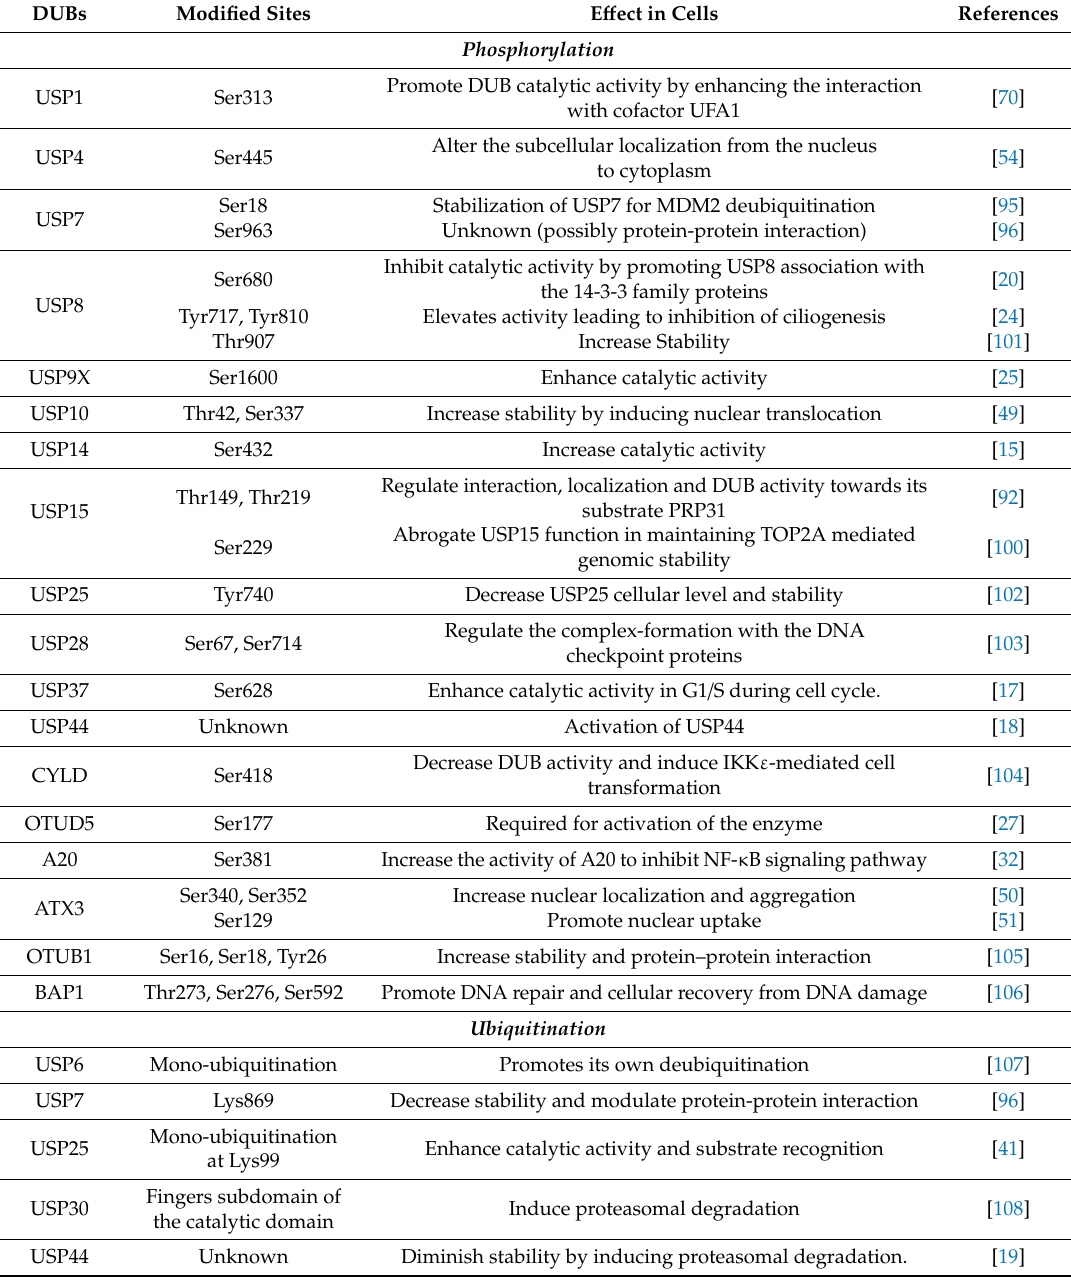
Table 1. Known PTMs of various DUBs. Listed are the names of DUB, modified sites, e ff ect in the cells according to PTM, as well as important